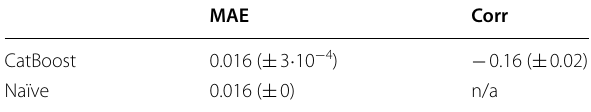
Table 2 Average mean absolute error (MAE) and rank correlation of the baseline CatBoost and naïve models, which only utilize clinical variables to predict segmentation quality.